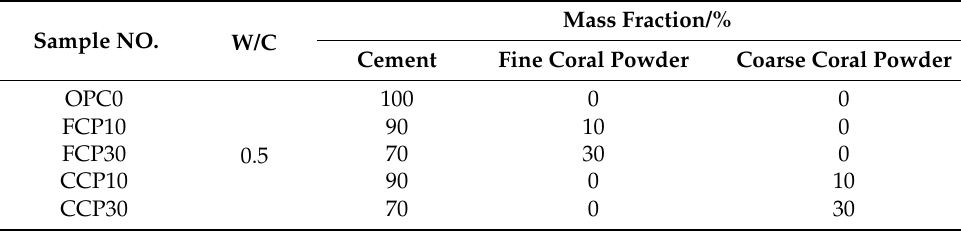
Table 2. The proportion of cement